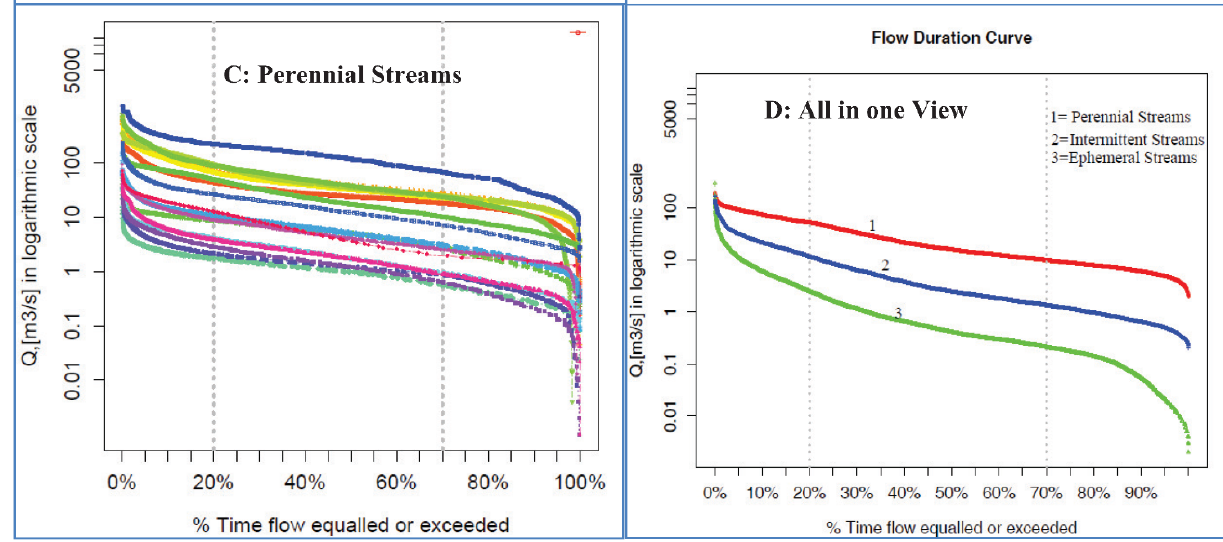
Figure 4. Flow duration curve (FDC) of streams for different flow regimes in Ethiopia. ( A ) Ephemeral streams; ( B ) Intermittent streams; ( C ) Perennial stream; ( D ) All in one view.